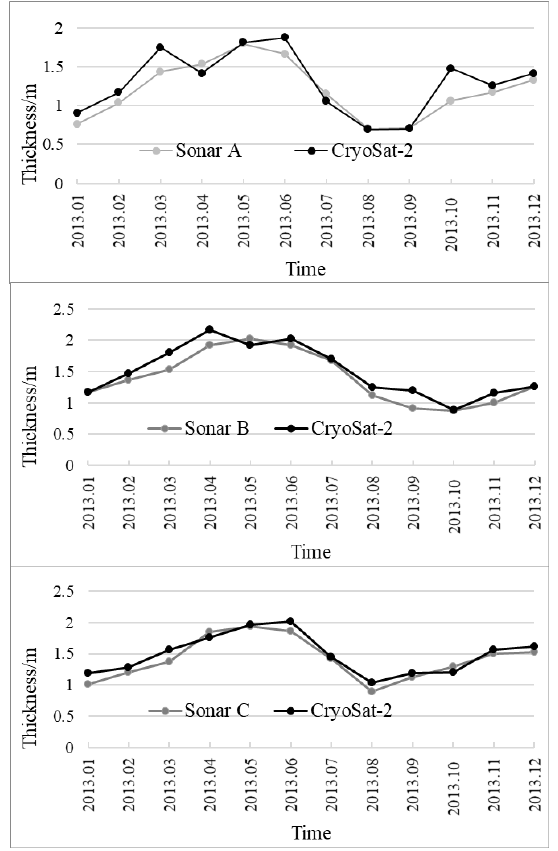
Figure 6. Comparison of ULS data from BGEP and the results in this